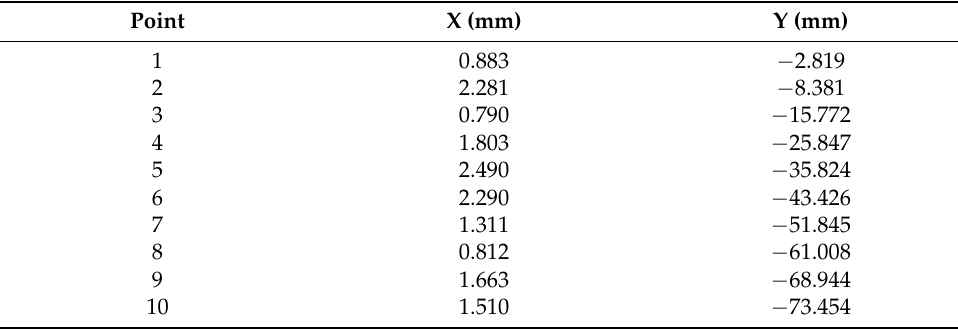
Figure 11. The finished counterpart without compensation.